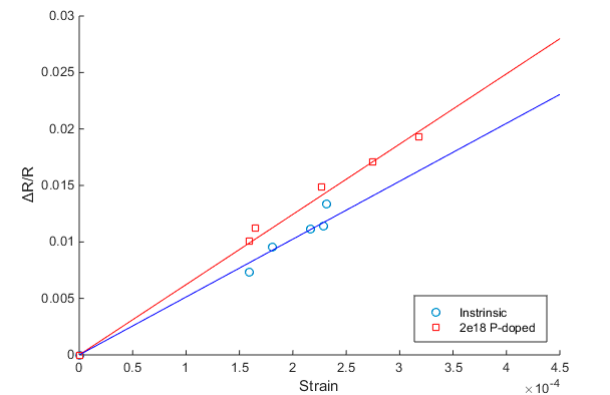
Figure 4. Change in resistance against